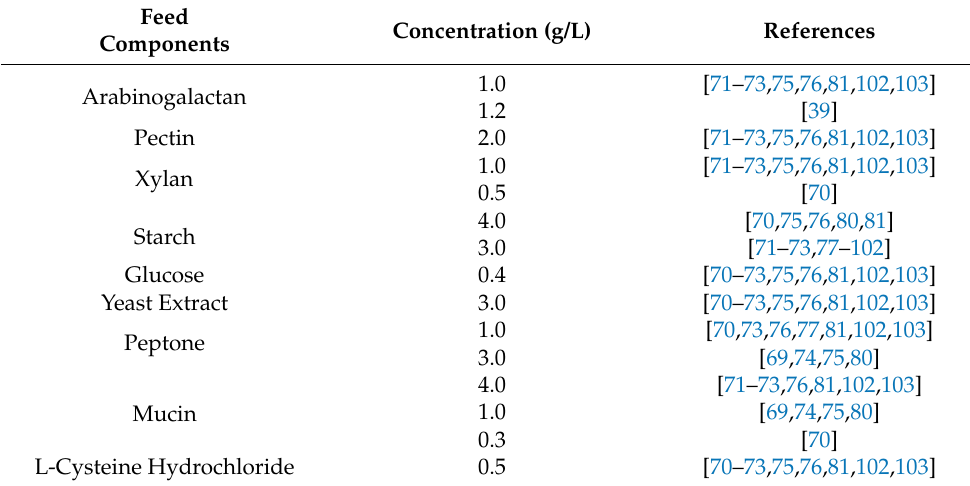
Table 1. Nutritional media composition of the administered feed to the SHIME model for the study of phenolic compounds, present throughout all digestive compartments.